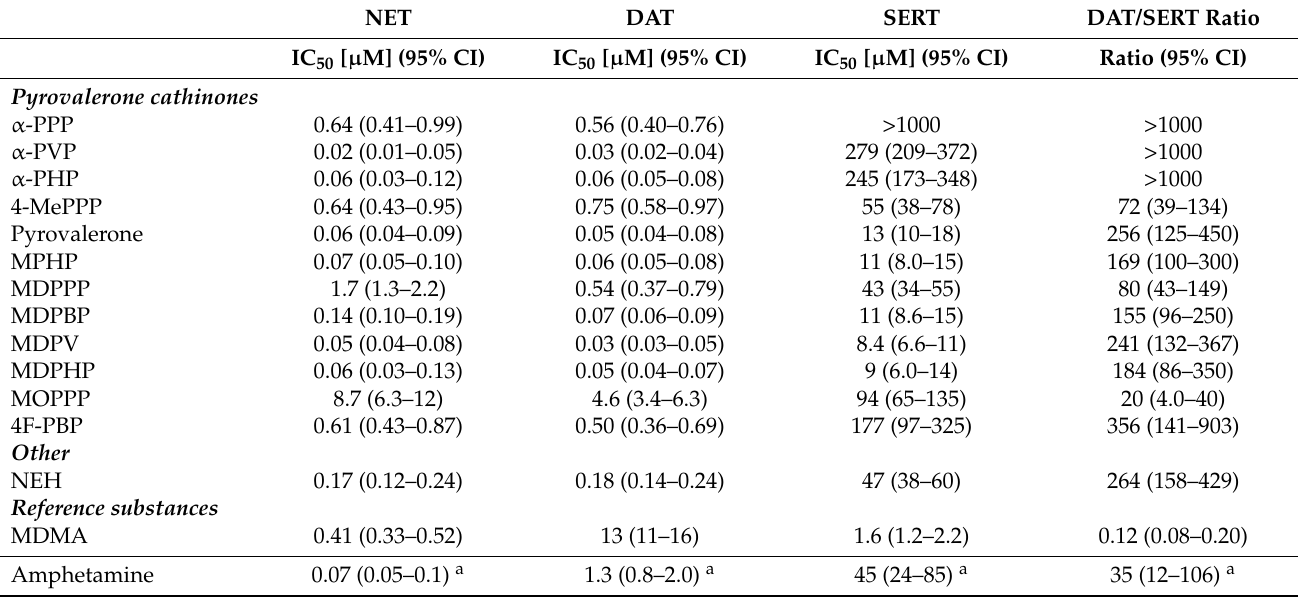
Table 1. Monoamine transporter